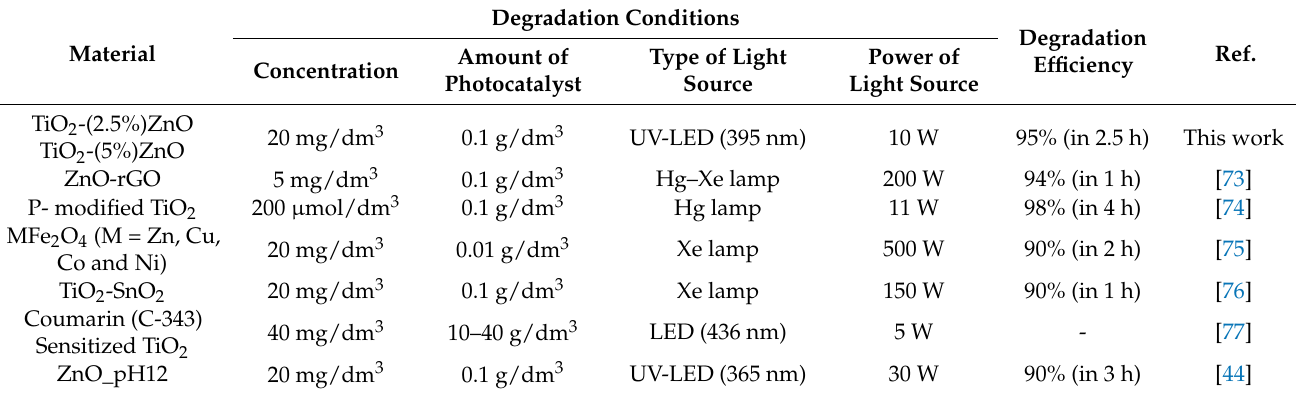
Table 5. Comparison of the photocatalytic performance of ZnO